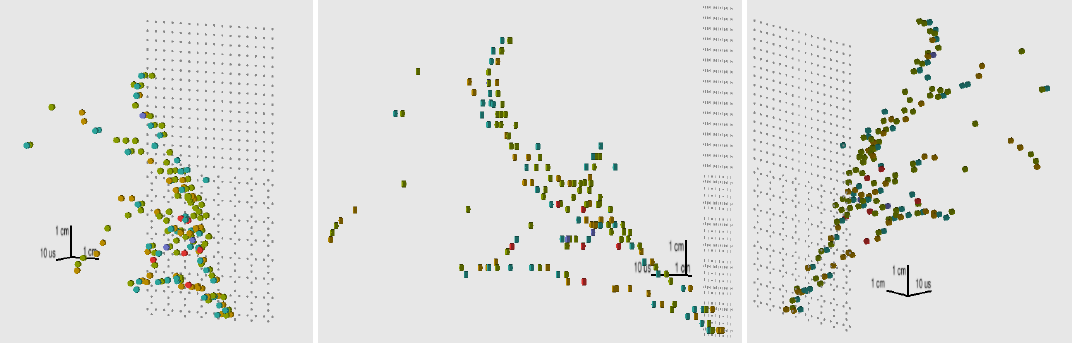
Figure 1. A prototype pixelated charge-readout Printed Circuit Board (PCB) developed as part of the ArgonCube R&D programme. The PCB has 832 pixels with various pad geometries, to identify optimal dimensions ( left ). Lawrence Berkeley National Laboratory’s (LBNL) LArPix Application-Specific Integrated Circuits (ASICs) are mounted directly on the rear of the PCB, providing cold signal digitization ( right ).